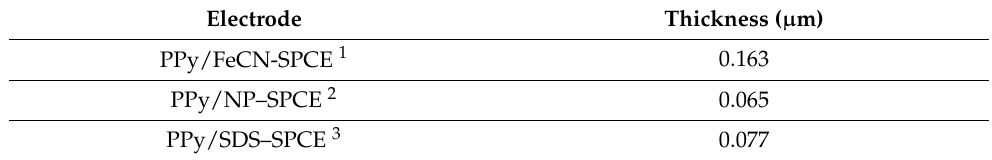
Table 1. The thickness of the polymer